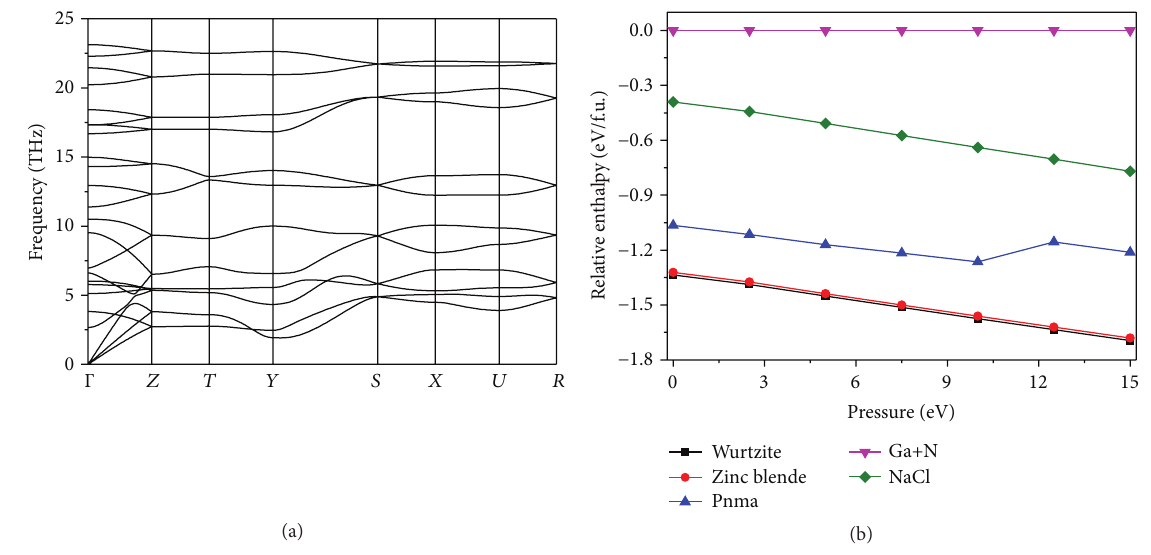
Figure 2: The phonon spectra of Pnma-GaN at ambient pressure (a); the related enthalpies of Pnma-GaN, wurtzite-GaN, zinc blende-GaN, and NaCl-GaN